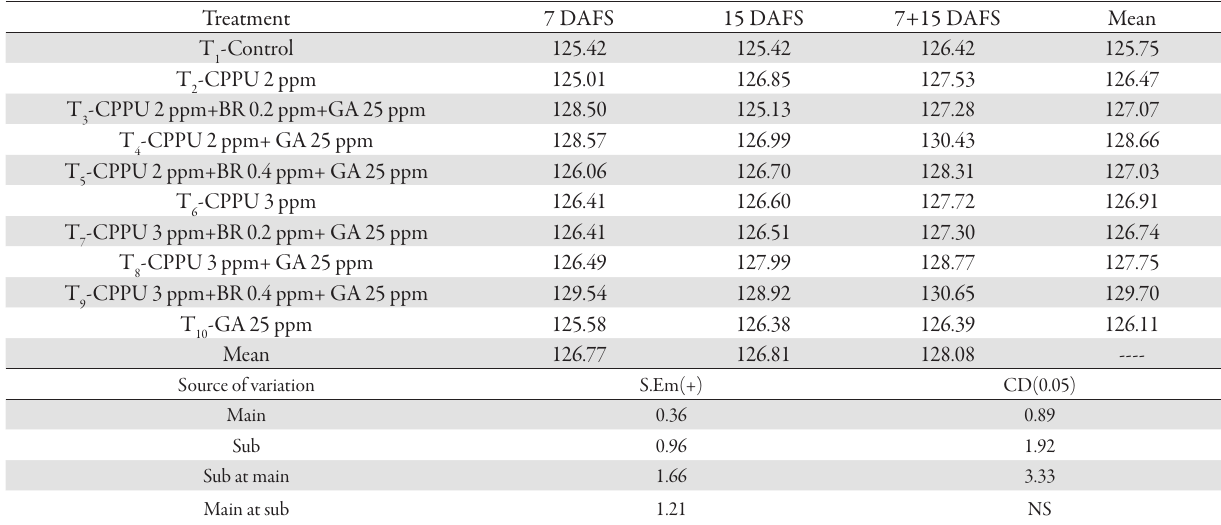
Tab. 2. Effect of growth regulators at different days after fruit set (DAFS) on leaf area(cm 2 ) in grape Cv. ‘Tas-A-Ganesh’